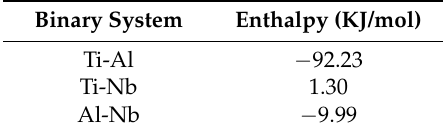
Figure 7. The distribution of the nearest neighboring atoms around Ti, Nb, and Al in Ti 15 Nb 45 Al 40 glassy alloy. Table 5. The heat of formation for each sub-binary system in Ti-Nb-Al ternary system